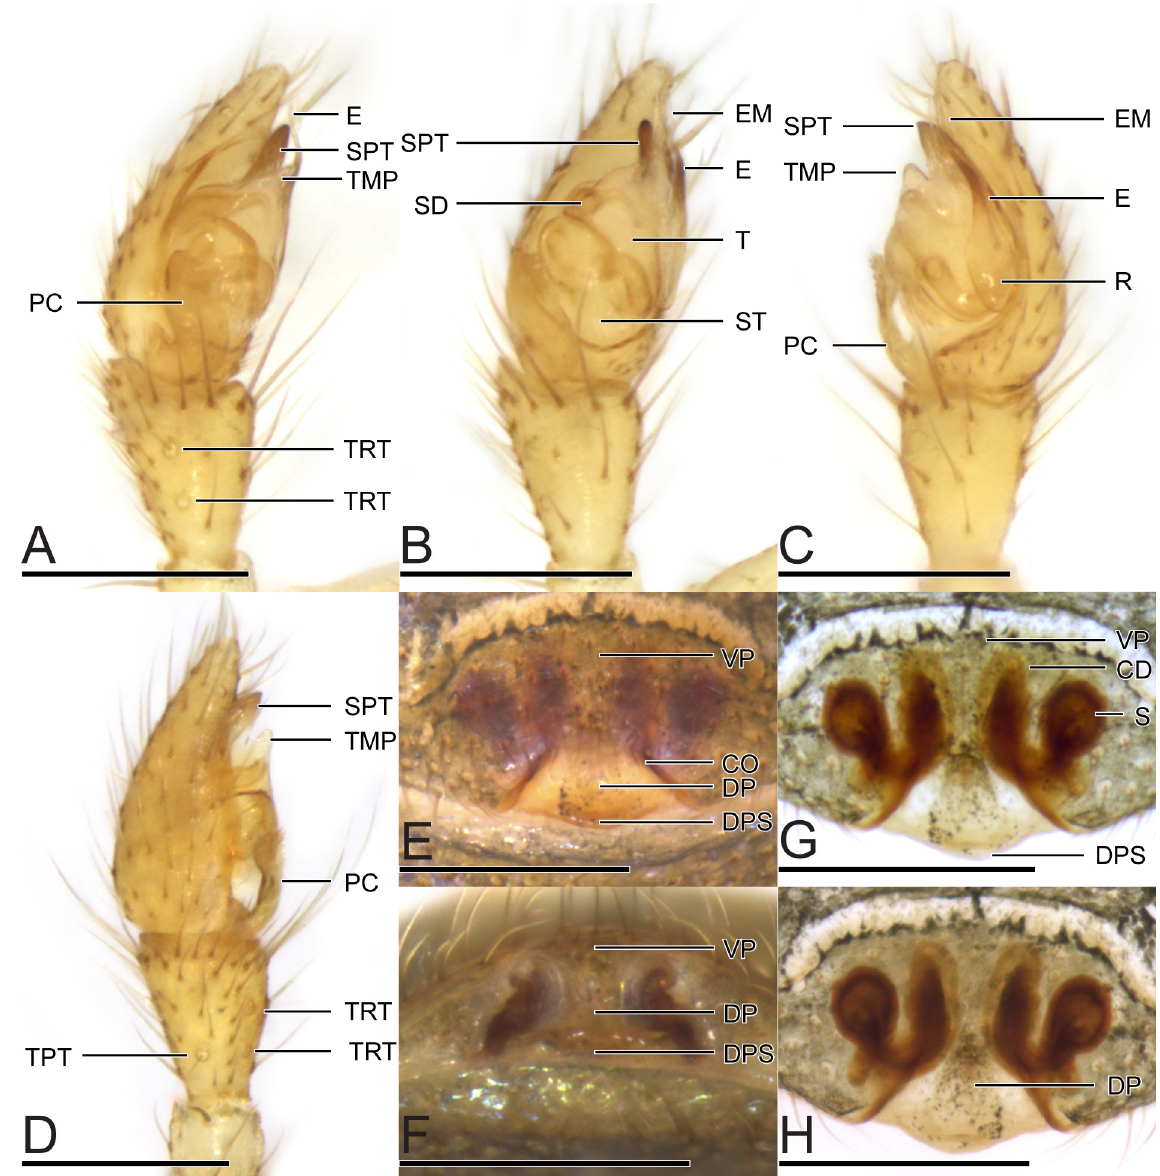
Fig. 10. Afroneta serrata sp. nov. A–D . ♂ (UPSZMC 67570). A . Palp, retrolateral. B . Ventral. C . Prolateral. D . Dorsal. E–H . Allotype, ♀ (UPSZMC 67569). E . Epigyne, ventral. F . Aboral. G . Cleared vulva, ventral. H . Dorsal. Scale bars: 200